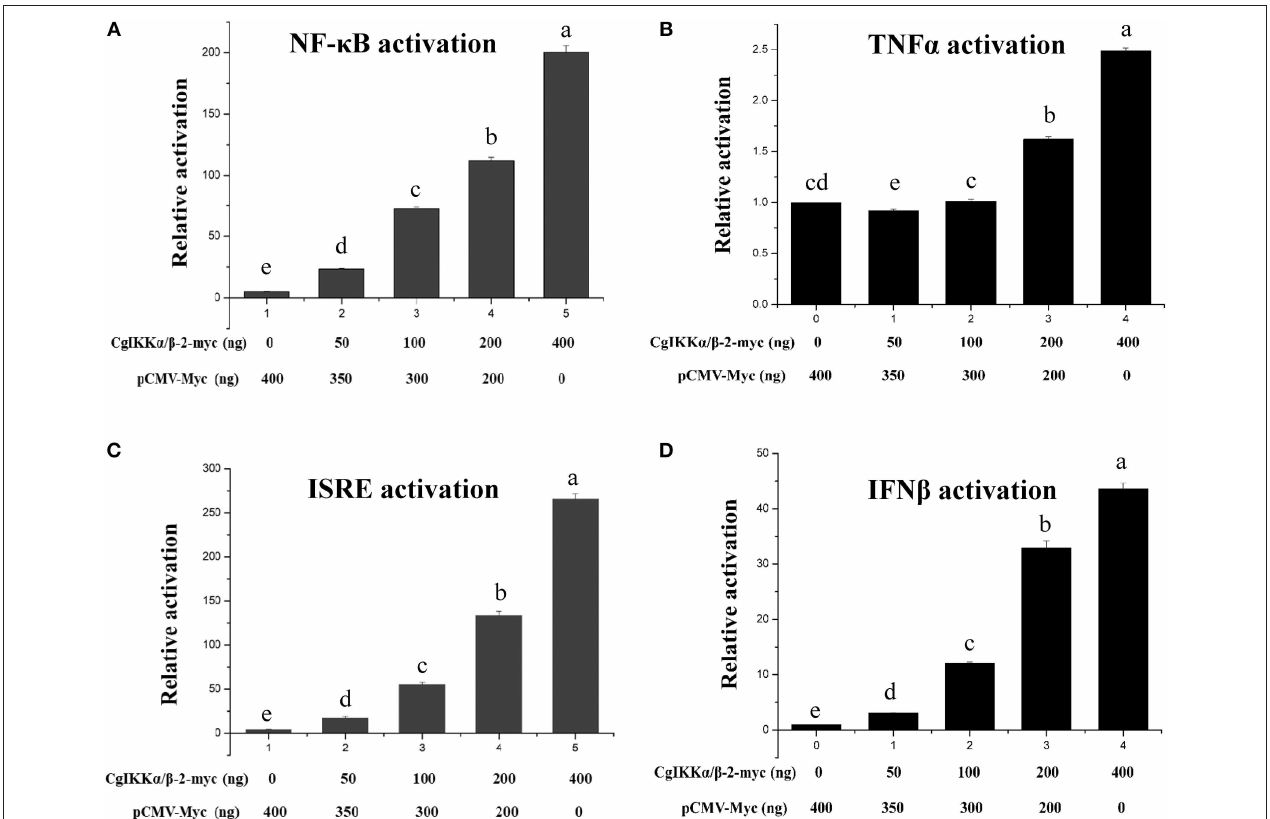
FIGURE 5 | CgIKK α / β -2 activated the NF- κ B (A) , TNF α (B) , ISRE (C) , and IFN β (D) promoters in a concentration-dependent manner. Activation was detected using dual luciferase reporter assays in human HEK293T cells. Results are displayed as the fold change from the control group. Vertical bars represent the mean ± SD ( N =